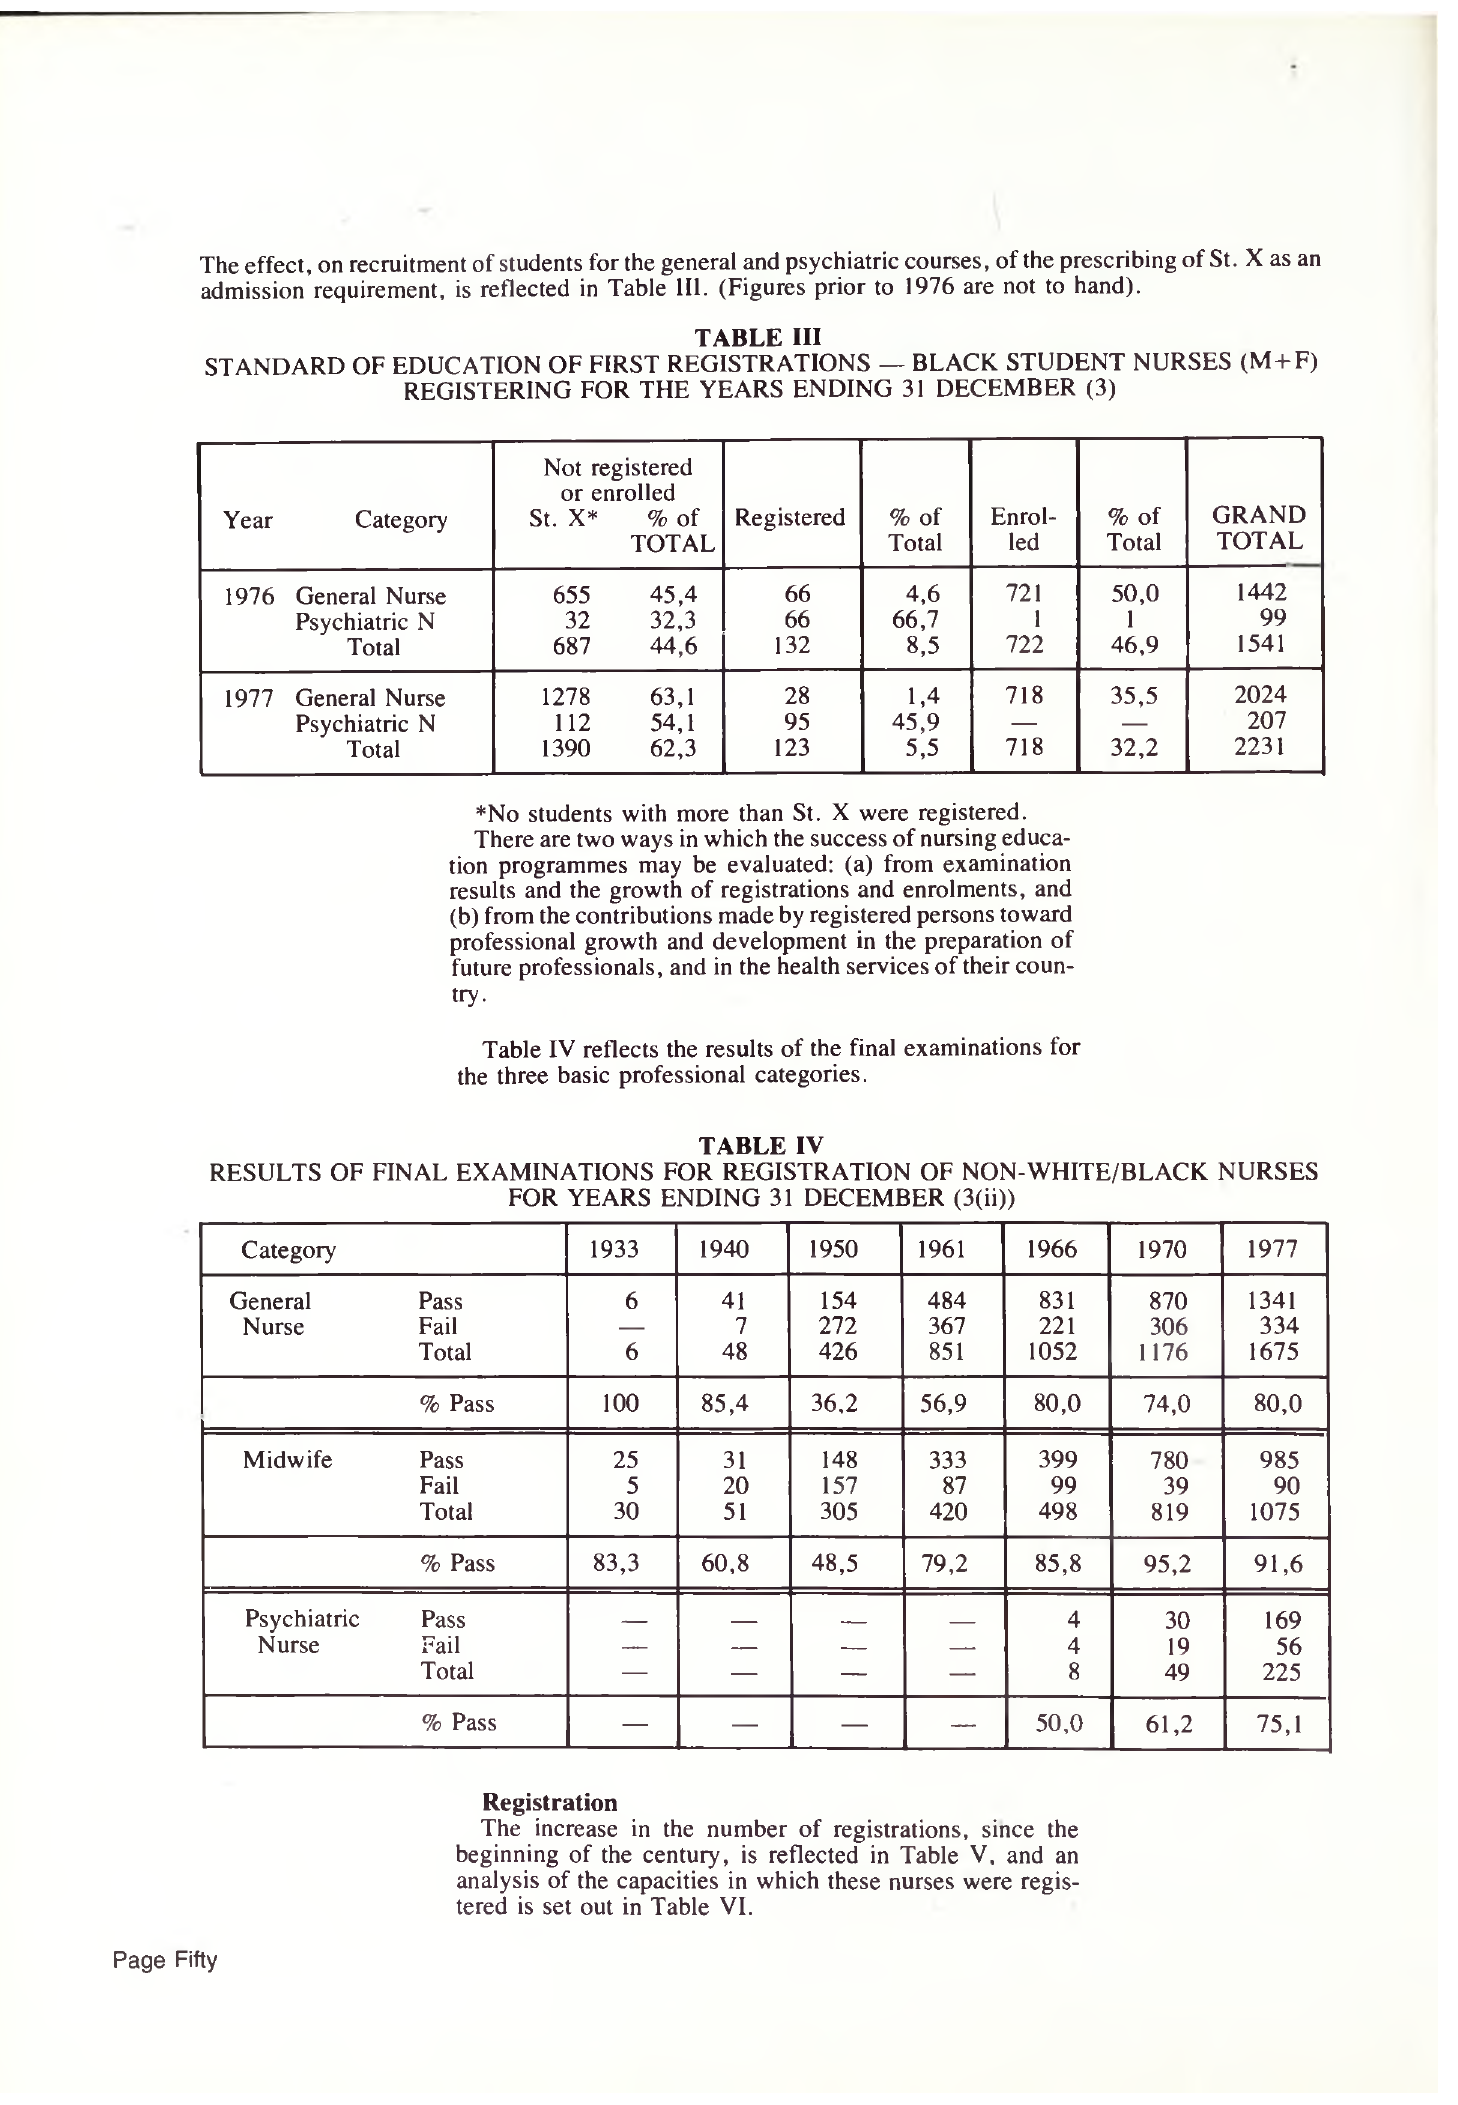
RESULTS OF FINAL EXAMINATIONS FOR REGISTRATION OF NON-WHITE/BLACK NURSES FOR YEARS ENDING 31 DECEMBER